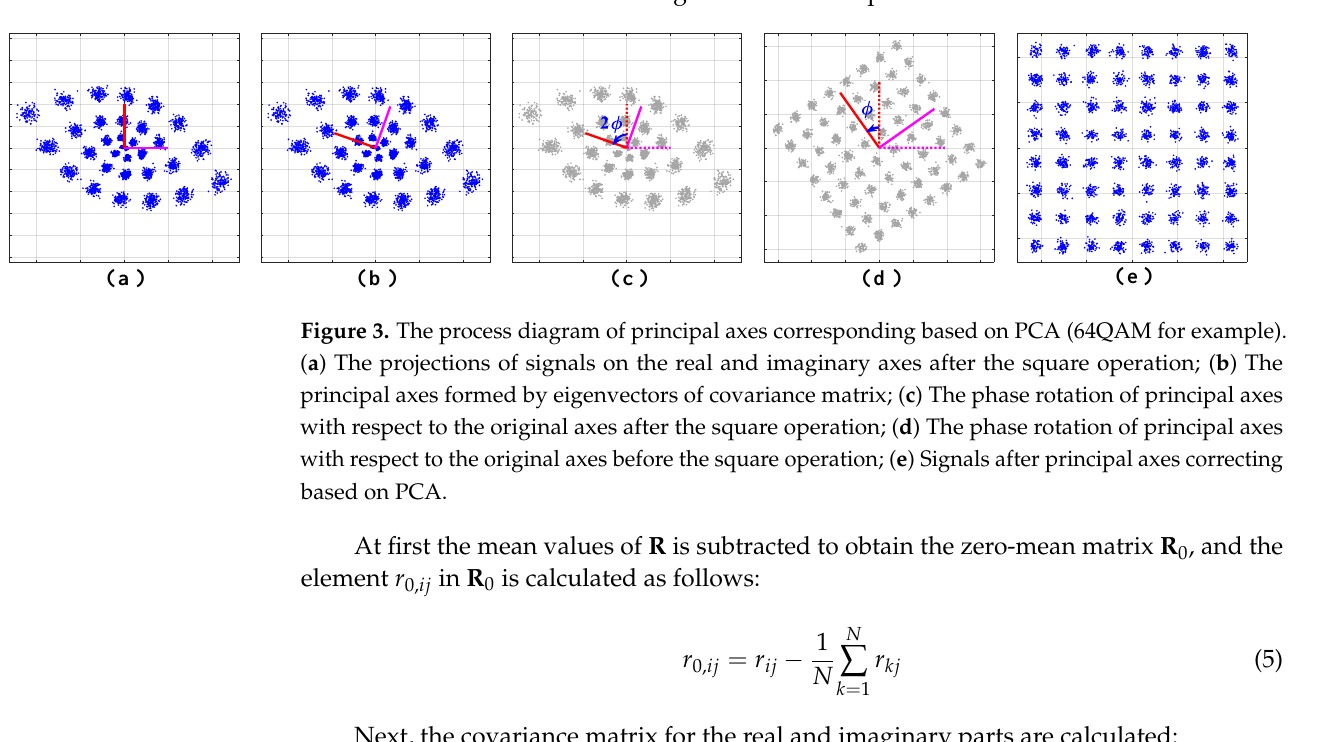
to the real axis (the magenta line Error! Reference source not found. a) and imaginary axis (the red line in Error! Reference source not found. a), respectively. It should be noted that here our signals suffer from phase rotation.